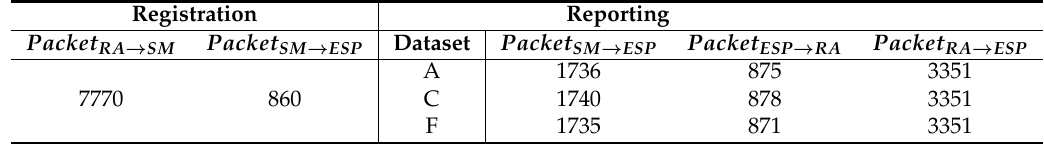
Table 4. Data volume exchanged among the entities in the two stages (bytes). Registration Reporting Packet RA → SM Packet SM → ESP